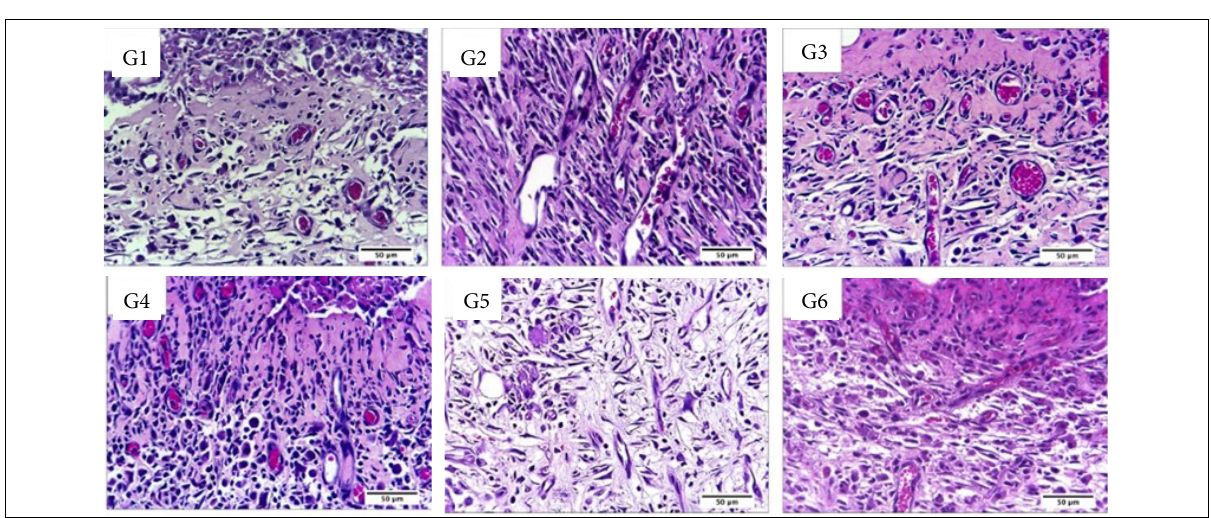
Figure 9 - Microscopic aspects of partial thickness burn wounds experimentally induced in Wistar rats and treated with silver-based dressings 7 DAI, scale bar = 50 μ